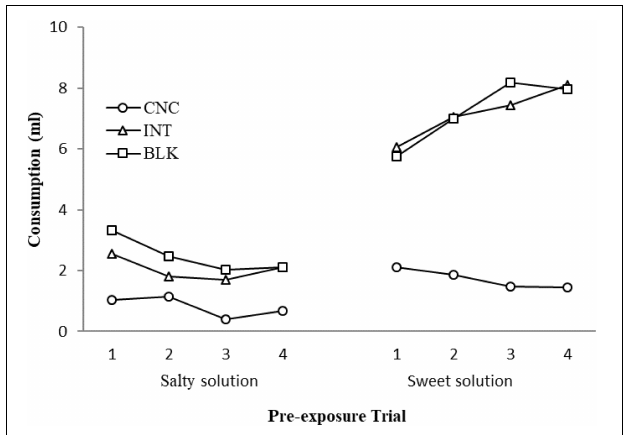
FIGURE 3 | Consumption (ml) of the salty and sweet solutions for the concurrent, intermixed, and blocked pre-exposure conditions across blocks of pre-exposure trials in Experiment